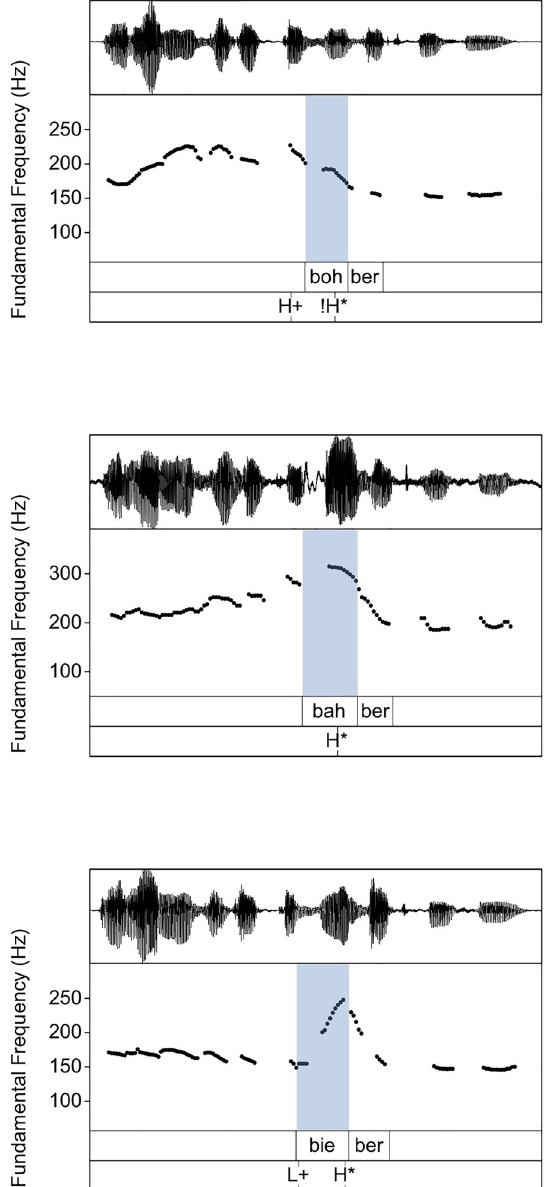
Fig 1. Examples of f0 contours: Three different nuclear pitch accent types from [35]. Top: Falling accent H+!H � . Middle: Slightly rising accent H � . Bottom: Rising accent L+H � . The shaded area marks the accented syllable of the target